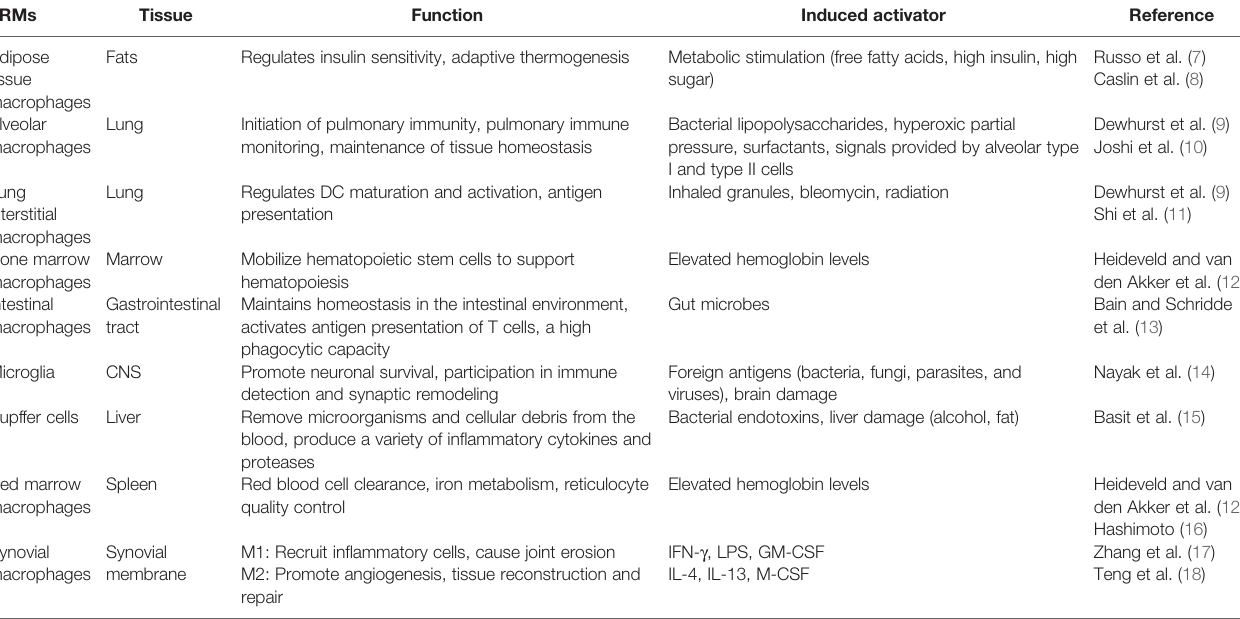
TABLE 1 | Markers and functions of tissue-resident macrophages